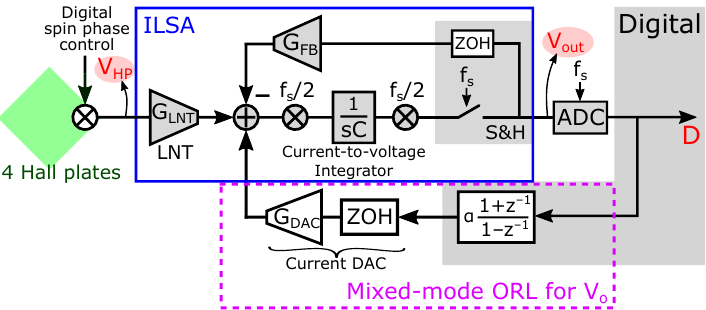
Figure 9. Simplified block diagram of what is implemented on the prototype chip: the In-the-Loop Sampling Amplifier (ILSA) (shown in the blue frame), which serves as the amplifier of the readout chain in this paper, a mixed-mode ORL for V o (shown in the purple square) and four Hall plates (shown in green) with digital spin phase control. Important signals are highlighted in red.